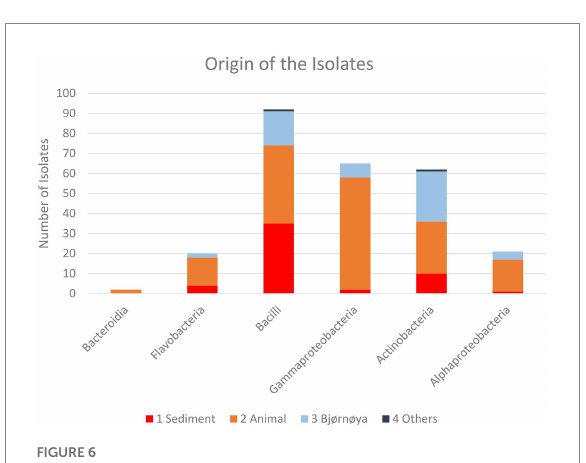
FIGURE 6 Taxonomic composition of the isolates recovered from the respective groups of sample sources for all sample treatments. Individual numbers and relative compositions are given in Table 3.